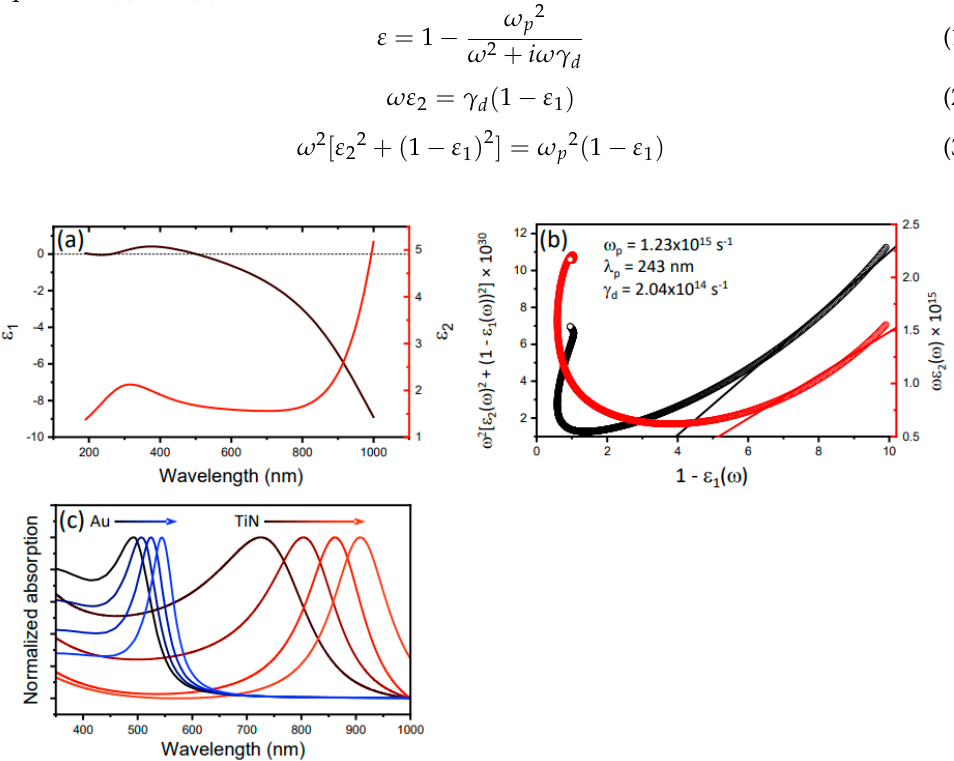
Figure 3. The measured real and imaginary components of the dielectric function are plotted in ( a ). The data is replotting in ( b ) according to Equations (2) and (3) allowing for the extraction of the plasma frequency and damping constant ( ω p = 1.23 × 10 15 s − 1 and γ d = 204 THz). Using the small particle dipole approximation, we calculate the expected plasmonic resonance for ellipsoids with aspect ratios varying from 1 to 2.5 for TiN (black to red) and compare to Au (black to blue) in ( c ).